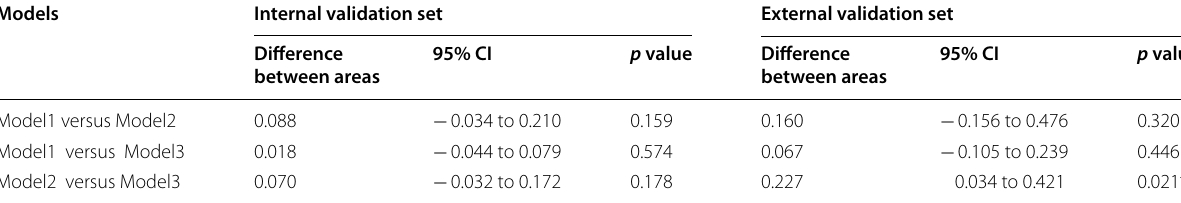
Model1: radiomics model; Model2: clinic-radiological model; Model3: combined model; CI, confidence interval * p < 0.05